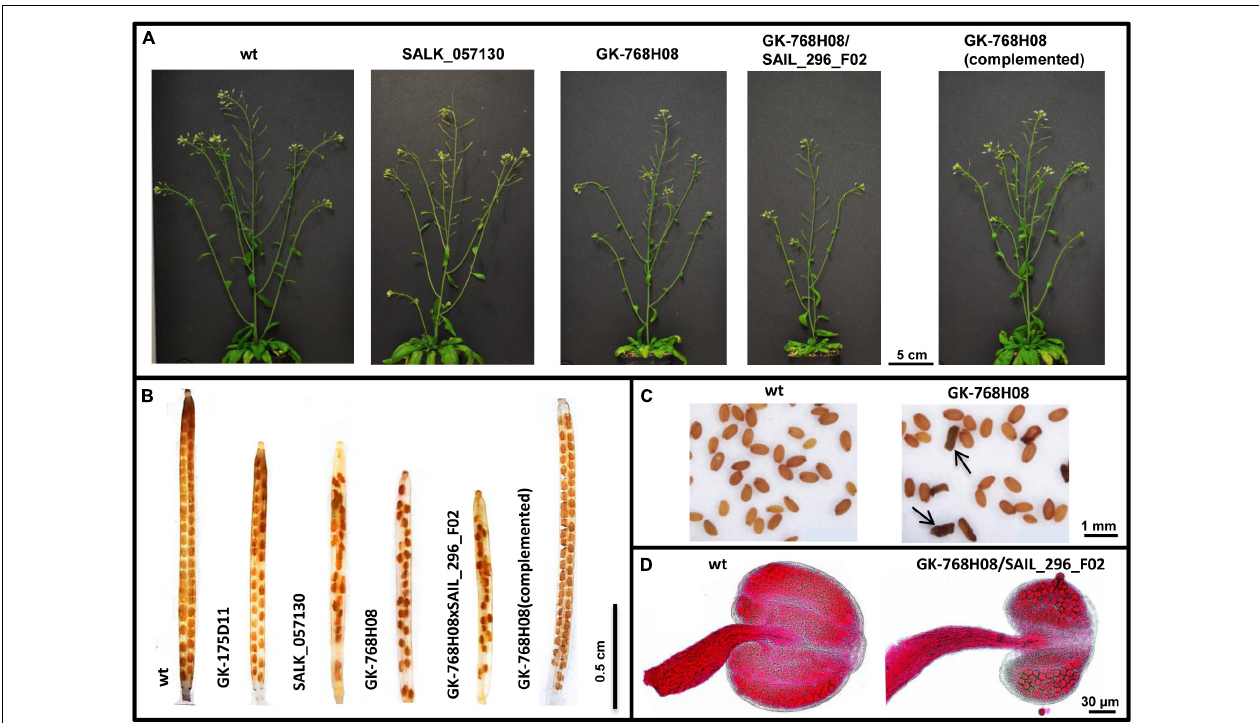
FIGURE 2 | Impaired growth and fertility of nse4 mutants compared to wild-type (wt). (A) Reduced plant size of the mutants GK-768H08 and the double mutant GK-768H08/SAIL_296_F02. Mutant SALK_057130 and the complemented GK-768H08 mutant show a wild-type habit. (B) Reduced seed set per silique in the nse4A and nse4B mutants. (C) Shriveled seeds (arrows) of the GK-768H08 mutant. (D) Reduced pollen grain number and aborted pollen grains in an anther of the double mutant GK-768H08/SAIL_296_F02.